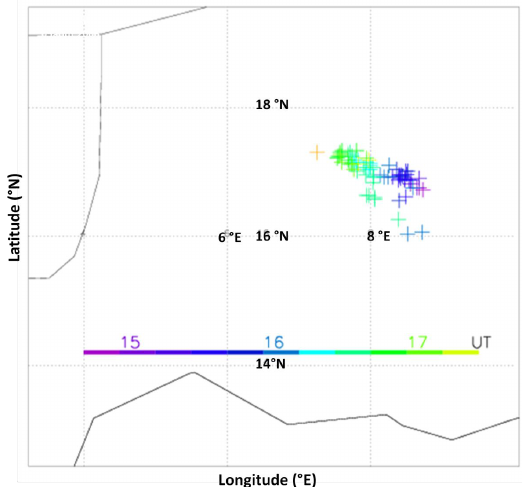
Fig. 5 Fig. 5. Same as Fig. 3 but for the A¨ır case from 14:45UT to 17:30UT on 5 August